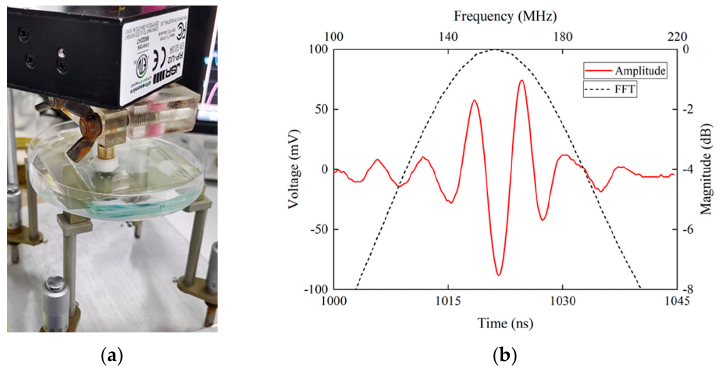
Figure 5. ( a ) Pulse-echo testing. ( b ) The waveform and frequency spectrum of the echo. Table 3. The performance parameters of the UHF ultrasonic transducer.